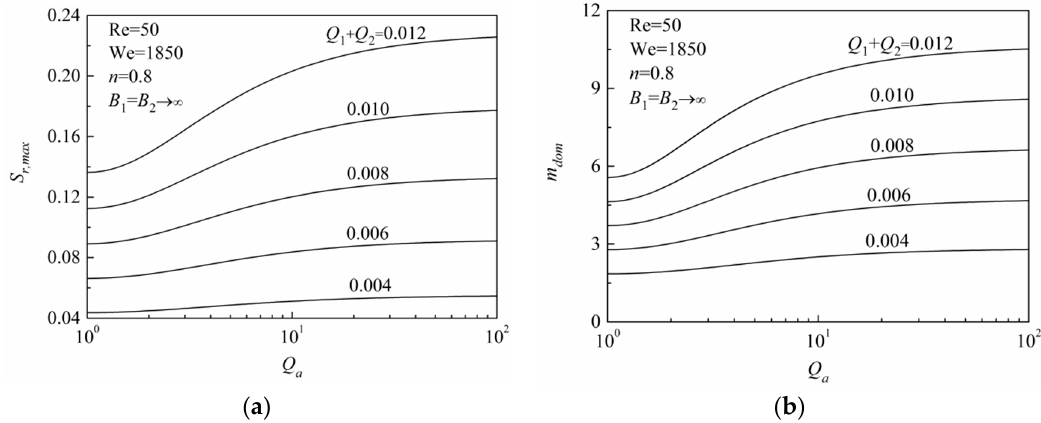
Figure 6. Effect of the aerodynamic asymmetry on jet instability at different total disturbance energy W with para-sinuous mode: ( a ) dimensionless maximum growth rate; ( b ) dimensionless dominant wave number.